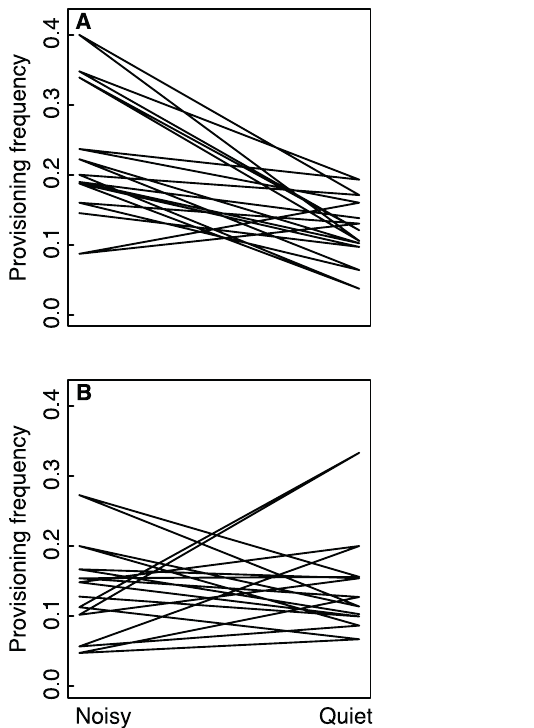
Figure 4. Frequency of provisioning (visits per minute) by female Lundy island house sparrows breeding in nestboxes affected by intermittent noise (top), and by those not affected by noise. Provisioning frequencies were calculated for the time period during which the noise was on and off in both groups. Lines represent changes in provisioning rate within individual females.